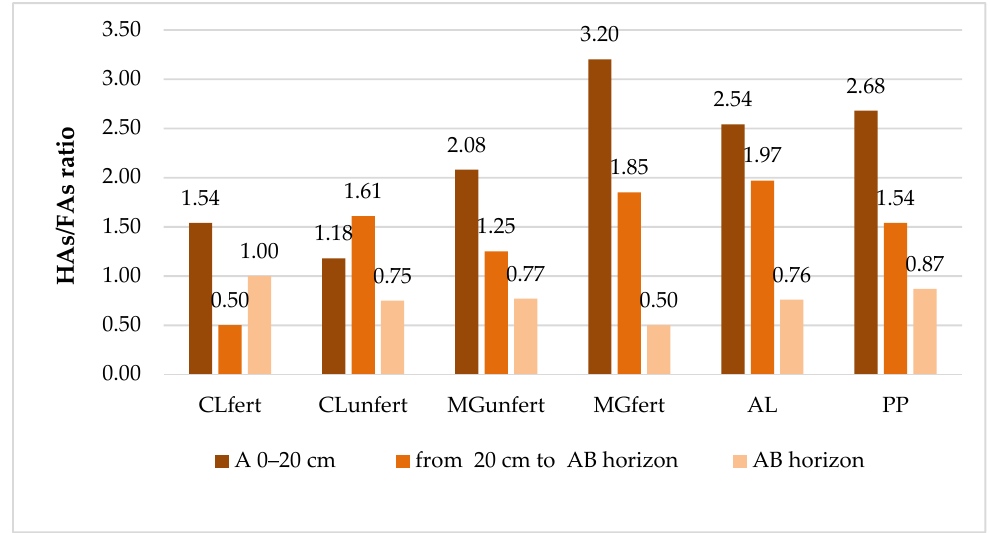
Figure 4. Ratio between humic and fulvic acids in soils of different types of land use. Note. Abbreviations: CLfert: cropland fertilized; CLunfert: cropland unfertilized; AL: abandoned land; MGunfert: managed unfertilized grassland; MGfert: managed fertilized grassland; AL: abandoned land; PP: pine plantation.